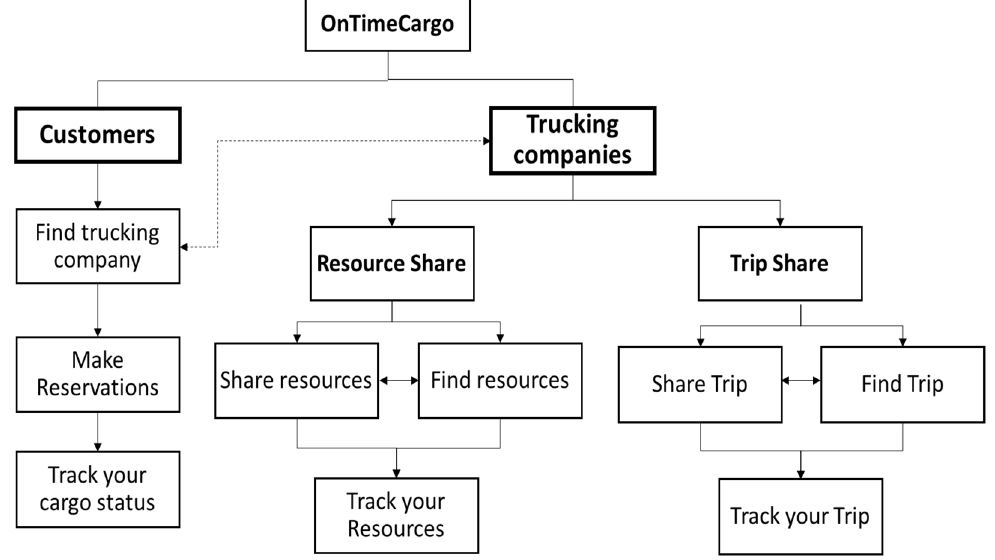
Figure 8. Improved information architecture (IA) after considering users’ feedback.